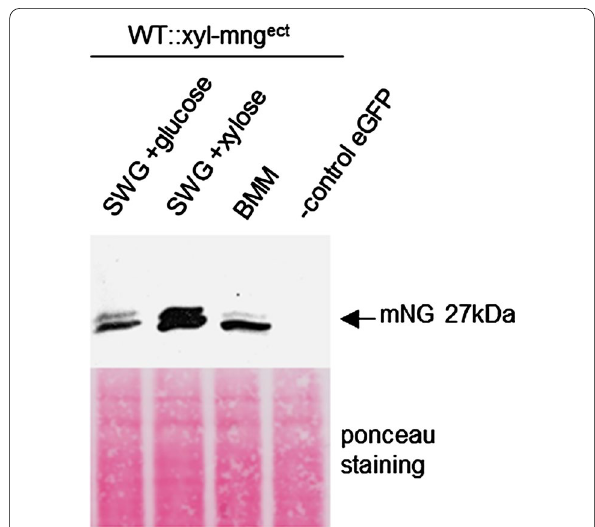
Fig. 3 Western-blot analysis of total protein extracts to demonstrate mng expression under control of the Smxyl promoter grown under non-inducing (SWG glucose) and inducing conditions + (SWG xylose), as well as in BMM. An S. macrospora wt transformant + carrying plasmid p1783 and expressing free eGFP served as a control. Ponceau red staining of the blot before the immunodetection served as loading